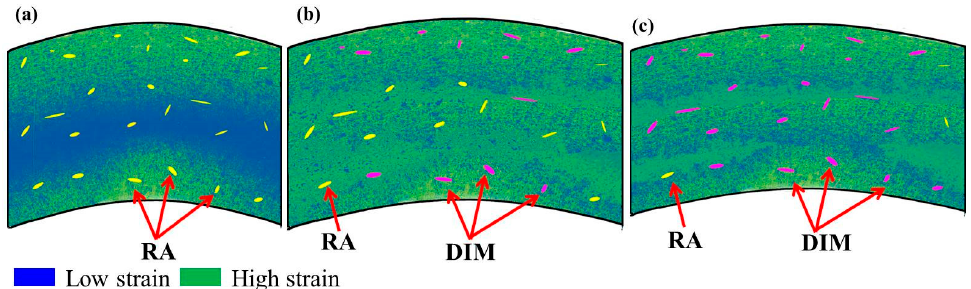
Figure 11. Schematic diagram of retained austenite transformation during the bending process. ( a ) QP specimens strained at low bending angle; ( b ) QP specimens strained at medium bending angle; ( c ) QP specimens strained at high bending angle. ‘RA’ and ‘DIM’ represent ‘retained austenite’ and ‘deformation-induced martensite’, respectively.